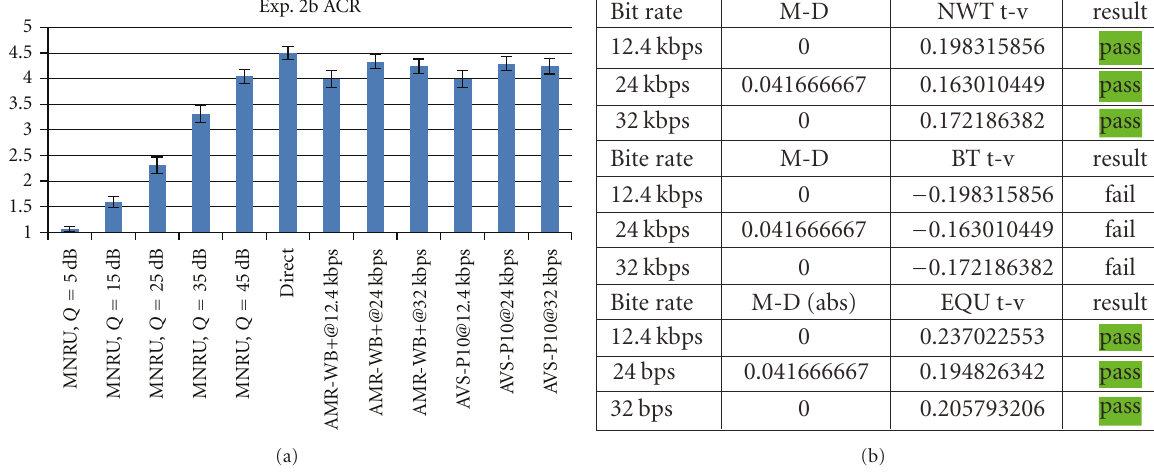
Figure 13: Experiment 2b MOS scores statistic analysis result and T -test result.